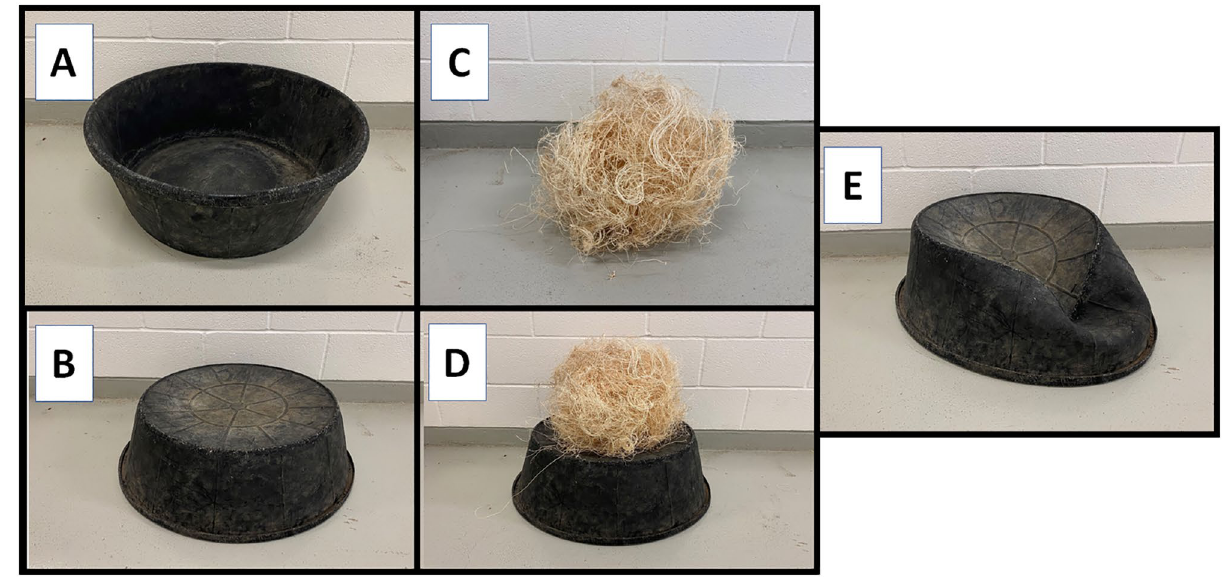
Figure 1. ( A ) Face-up tub. ( B ) Face-down tub. ( C ) Excelsior. ( D ) Excelsior placed on tub (‘tub-stack’). ( E ) Broken